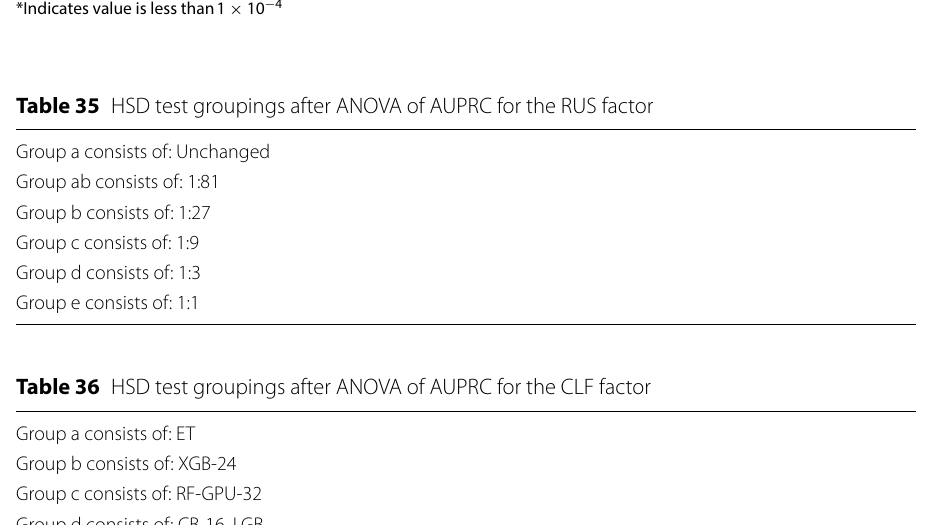
*Indicates value is less than 1 × 10 − 4